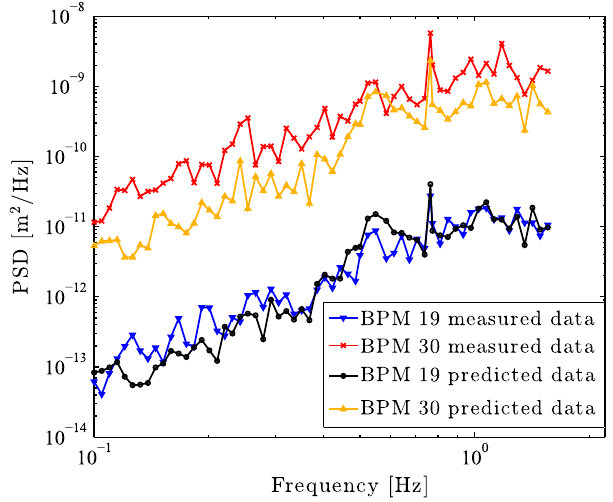
FIG. 13. Power spectral densities of the BPM measurements and the predictions from the ground motion sensors in vertical direction for the BPMs 19 and